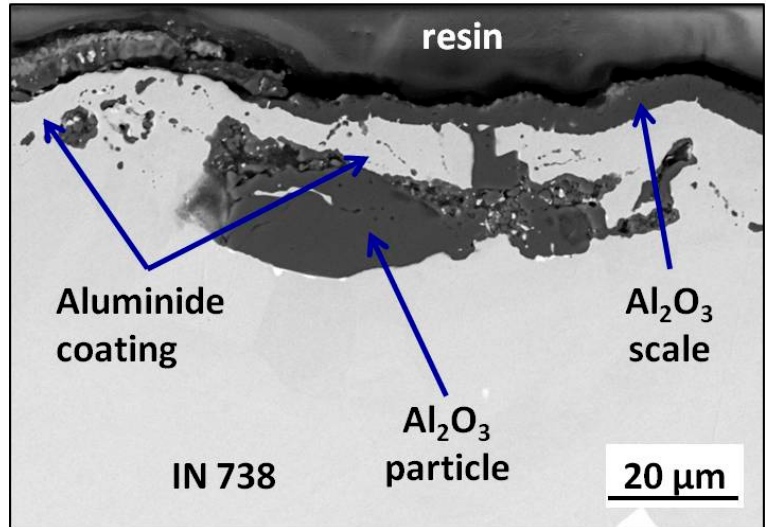
Figure 15. SEM/BSE image showing cross-section of an aluminide coating formed on grit-blasted IN 738 after a thermal shocking test after 200 cycles, showing the influence of embedded alumina particle originating from grit blasting of the substrate surface on the oxidation behavior of the complete system.